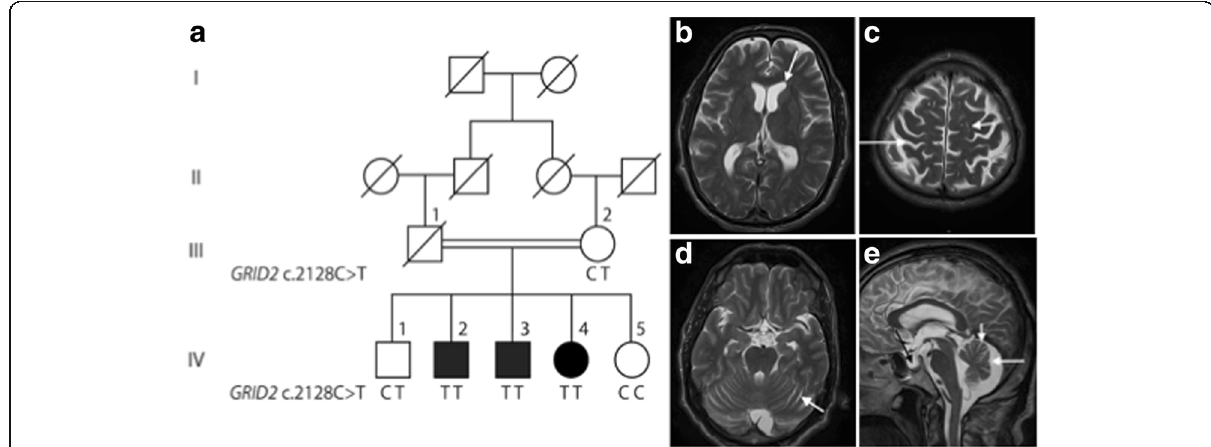
Fig. 1 Pedgree, genotypes and MRI of the consanguineous family segregating the GRID2 variant ( a ) Pedigree and genotypes of the consanguineous family segregating GRID2 mutation c.2128C > T, p.(Arg710Trp). ( b ) MRI findings in ind. V:2 showing slight to moderate widening of cerebral ventricles (arrow). ( c ) Slight to moderate widening of cerebral sulci (long arrow) and prominent perivascular spaces (short arrow). ( d ) Slightly widened cerebellar sulci (short white arrow). ( e ) Widened cerebellar sulci (short white arrow). The retrocerebellar arachnoid cyst with slight compression of the vermis (long white arrow) and some degree of intrasellar cisternal herniation (black arrow) are likely incidental findings. The combined MRI findings indicate a slight and general brain atrophy without involvement of the brainstem. Transverse ( b - d ) and sagittal ( e ) T2-weighted images. Images were obtained on a 1.5 T scanner, and included sagittal T1- and T2-weighted and axial T2-weighted images with a slice thickness of 5 mm. The abnormalities were assessed qualitatively and based on age related reference subjects